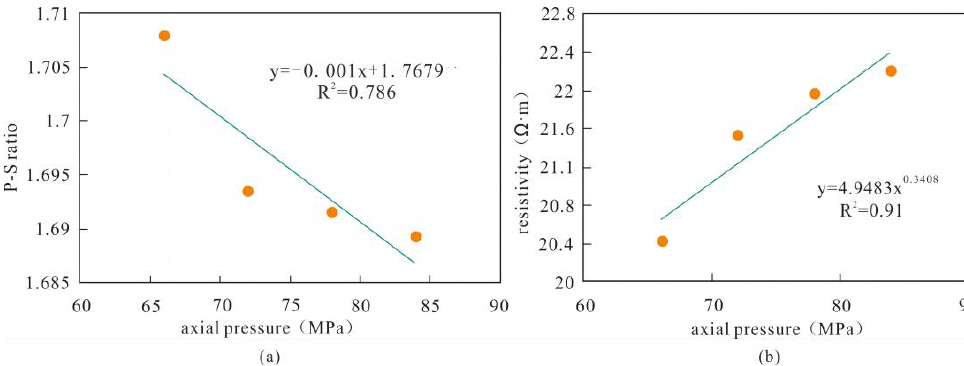
Figure 13. Correlation curves between P − S wave ratio, resistivity and axial pressure.